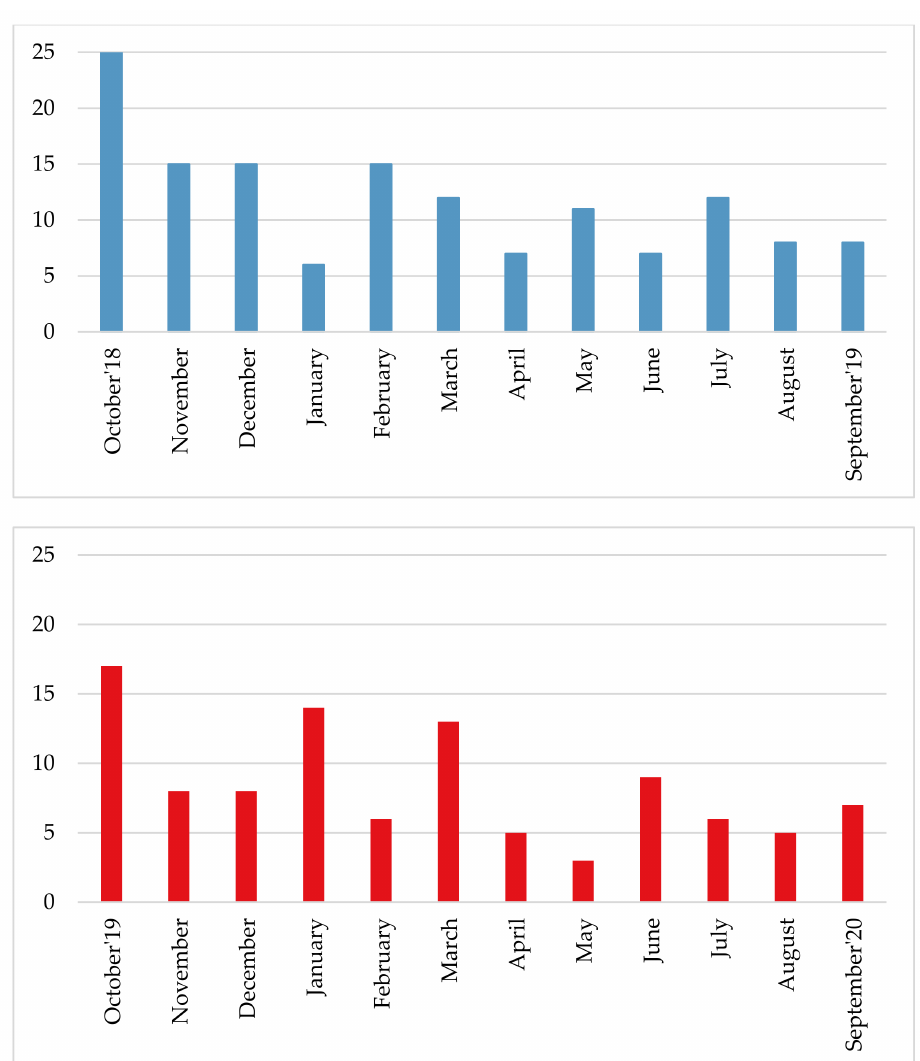
Figure A2. Reports of gunshots pre-COVID-19 (blue) and during COVID-19 (red) in Mexico City for each month. September includes 6 days of October. Source: Authors’ own with office